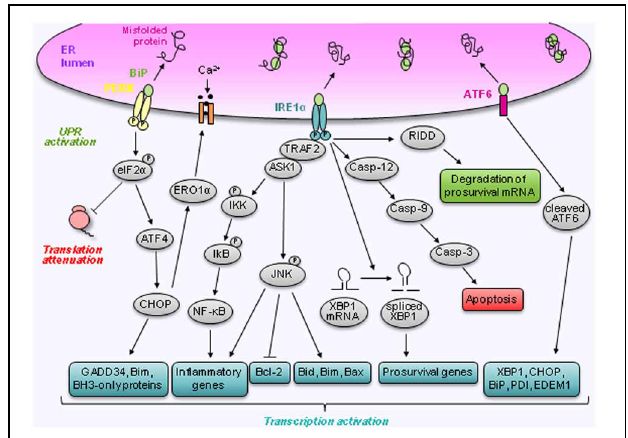
FIGURE 2 | Regulation of prosurvival and apoptotic pathways by ER stress. Cells cope with ER stress by activating the unfolded protein response. This response is mediated via the dissociation of BiP from three ER transmembrane proteins IRE1 α , PERK, and ATF6. Following dissociation of BiP, IRE1 α becomes activated and induces splicing of XBP1 mRNA to XBP1s. IRE1 α also activates JNK via TRAF2 and ASK1. Furthermore, activation of IRE1 α has been linked to downstream NF- κ B activation and RIDD, which can lead to the degradation of prosurvival mRNA. Finally, IRE1 α controls the activation of the caspases signaling pathway. Like IRE1 α , PERK becomes activated following BiP dissociation. Active PERK mediates its response via phosphorylation of eIF2 α leading to a translational block and cap independent translation of ATF4. ATF4 induces CHOP which has multiple downstream targets that stimulate apoptosis and cell death. Following BiP dissociation, ATF6 is transported to the Golgi where it is cleaved into an active transcription factor. ATF6 regulates the expression of several genes involved in the unfolded protein response such as XBP1, CHOP, BiP, PDI, and